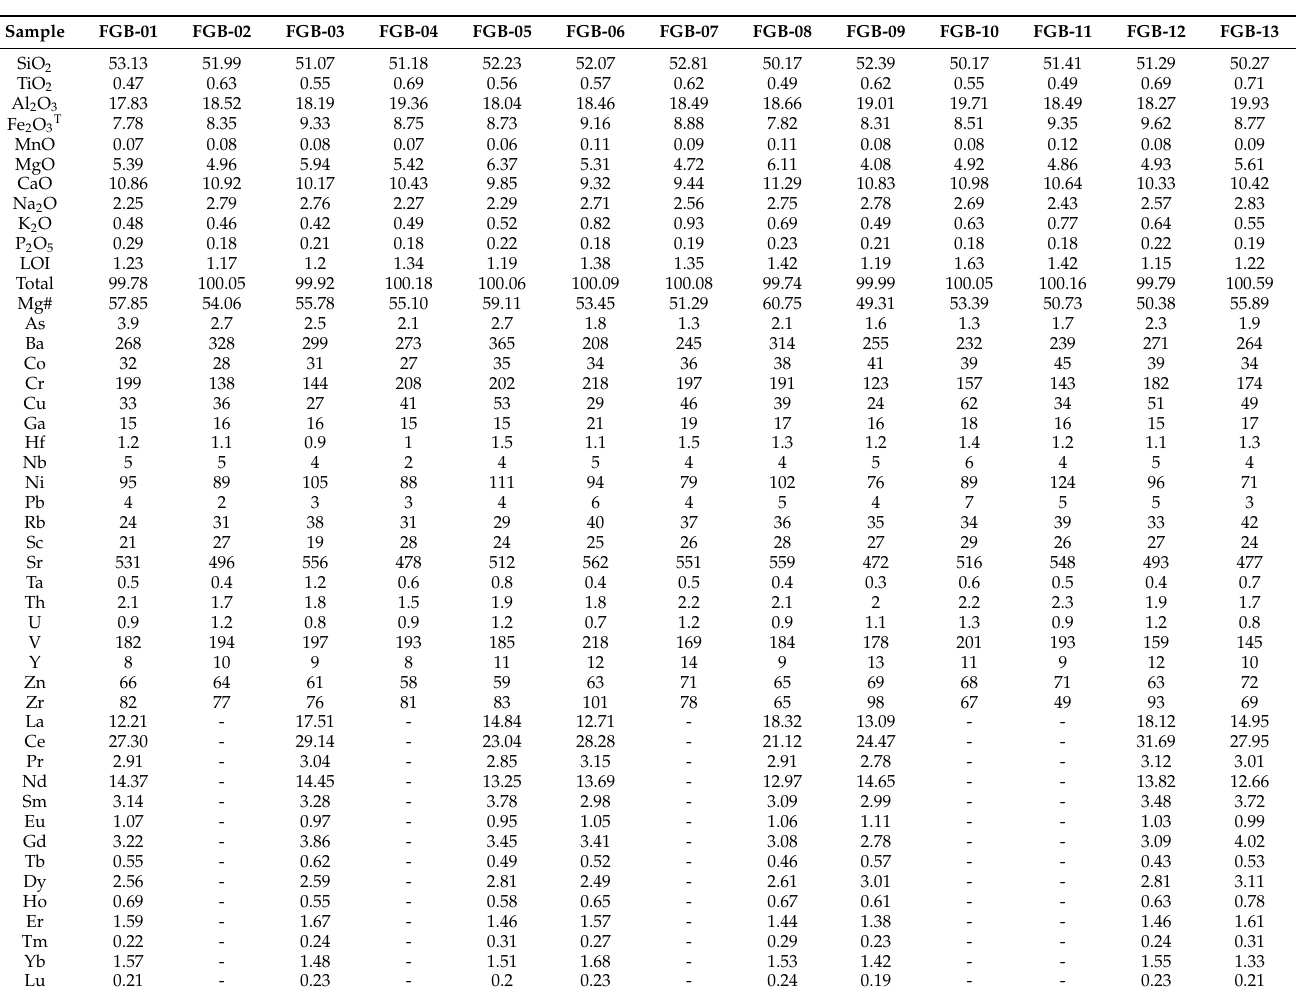
Table 1. Bulk-rock (major, trace and REEs) geochemical data of the Wadi El-Faliq gabbro, central Eastern Desert,